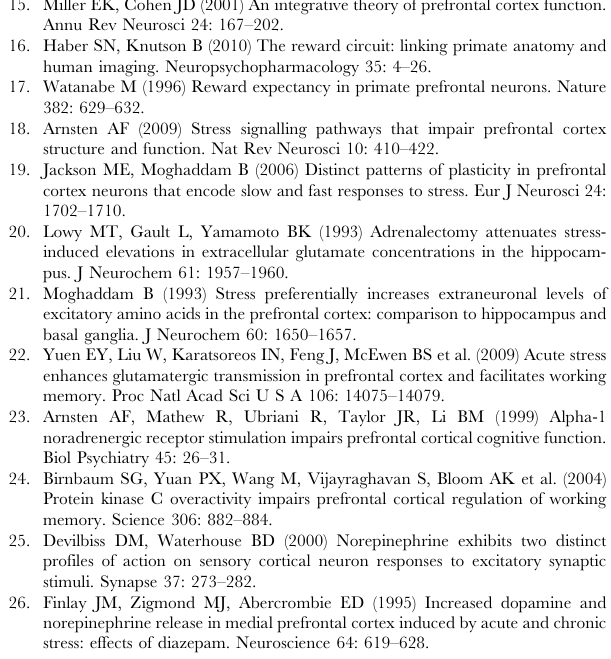
Figure S1 Stress-related changes in pl PFC neuron spike-history predicted discharge (SHPD) throughout baseline and acute stress conditions quantified using Model 1b. A ) SHPD at different points back in time decay exponentially under baseline and stress conditions for the same ensemble of neurons used for Model1a.